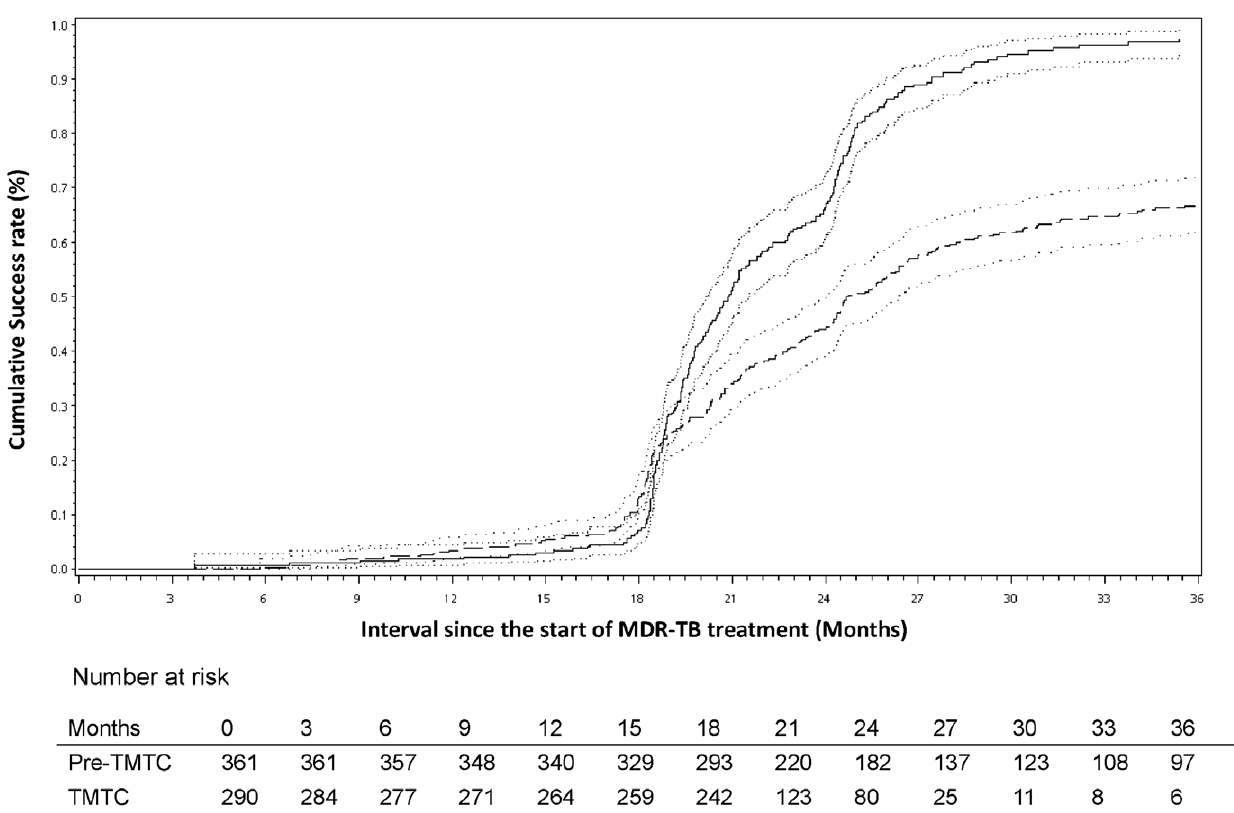
Figure 3. Treatment outcomes of 651 multidrug-resistant tuberculosis (MDR-TB) patients after the administration of second-line drugs. The cumulative success rate reveals that patients in the Taiwan MDR-TB Consortium (TMTC) era had a higher probability of treatment success than patients in the pre-TMTC era. Dashed line, pre-TMTC era; solid line, TMTC era; dotted line, 95% confidence interval ( p , 0.001 by the log-rank